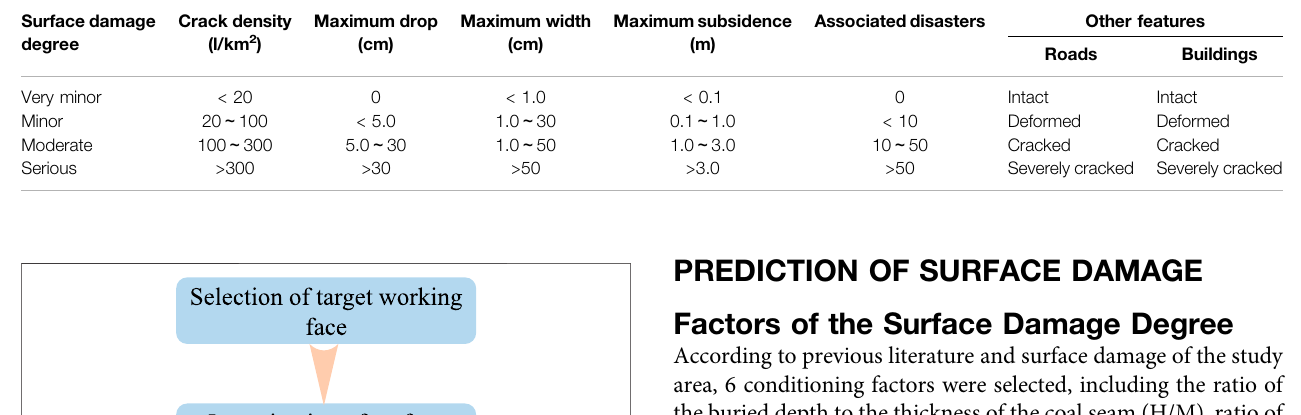
TABLE 3 | The degree of surface damage.